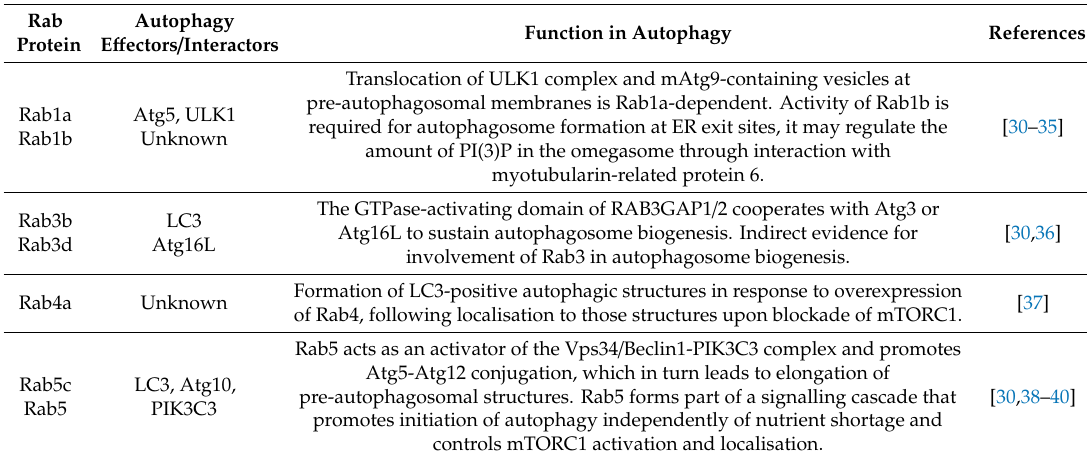
Table 1. Rab GTPase proteins, and their autophagic e ff ectors / interactors that function in autophagosome biogenesis and